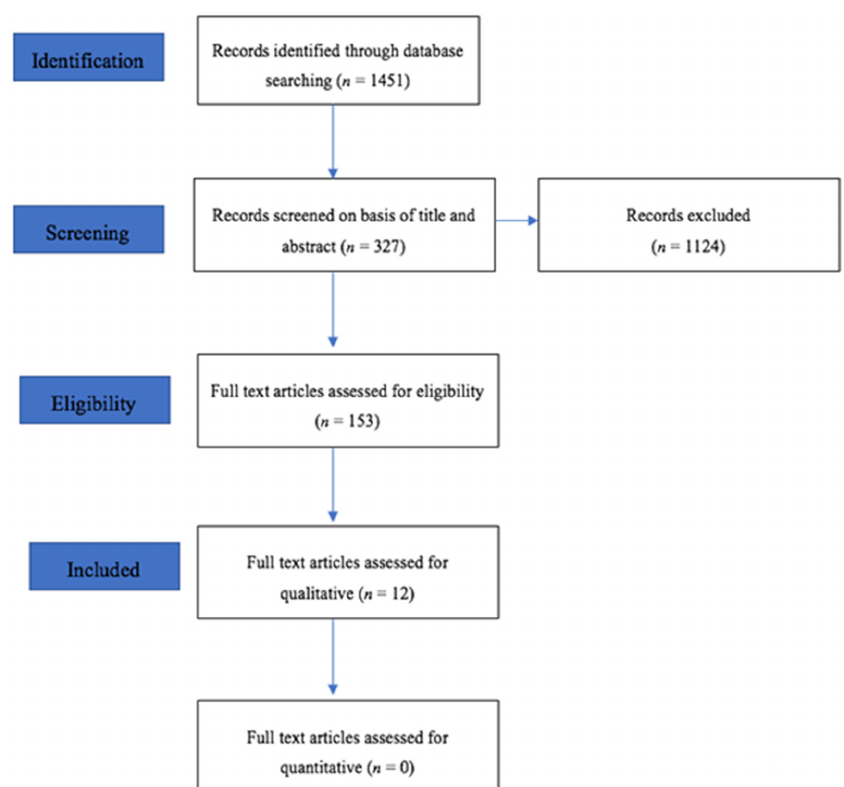
Figure 1. PRISMA flow diagram of the literature search and selection process. PRISMA—Preferred Reporting Items for Systematic Reviews and Meta-Analyses.